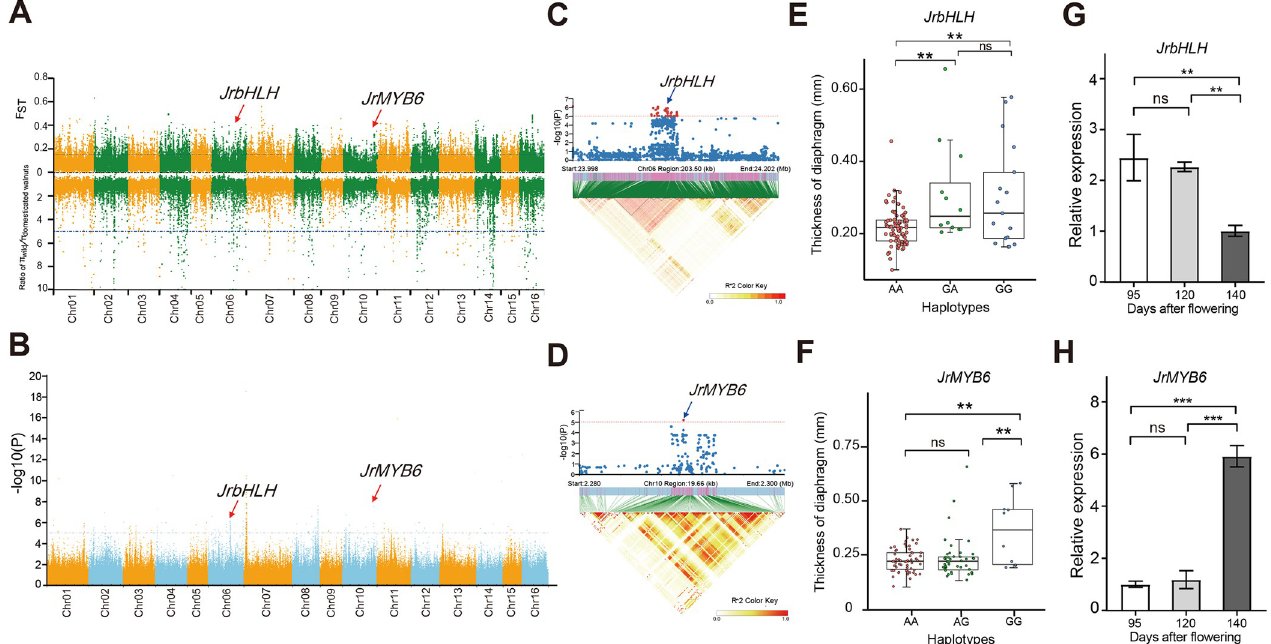
Fig 4. Selective sweeps and GWAS of diaphragm thickness. (A) Distribution of the F ST and nucleotide diversity (ROD) for the wild group and cultivar +landrace group ( π wild / π cultivar+landrace ; domesticated) in windows along chromosomes. Horizontal dotted lines represent the cutoff fulfilling the requirement for regions under selection. The dashed line indicates the F ST = 0.15. The red arrow indicates the selected loci in JrbHLH and JrMYB6 . (B) Manhattan plot for GWAS on the thickness of the diaphragm in the full population. The dashed line indicates the threshold − log(P) = 5. The red arrow indicates the SNP in JrbHLH and JrMYB6 . Manhattan plot (top) and linkage disequilibrium heat map (bottom) for JrbHLH (C) and JrMYB6 (D). Box plots show the thickness of the diaphragm in three haplotypes (Hap.) of JrbHLH (E) and JrMYB6 (F). Relative expression levels of TF JrbHLH (G) and JrMYB6 (H) in three development stages of the walnut diaphragm. �� P < 0.01, ��� P < 0.001, ns = not significant, Student’s